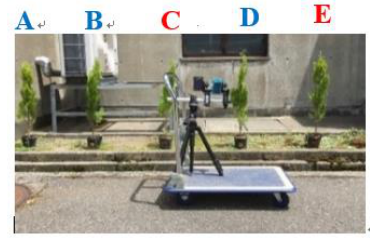
Figure 18. Observe conifers from a